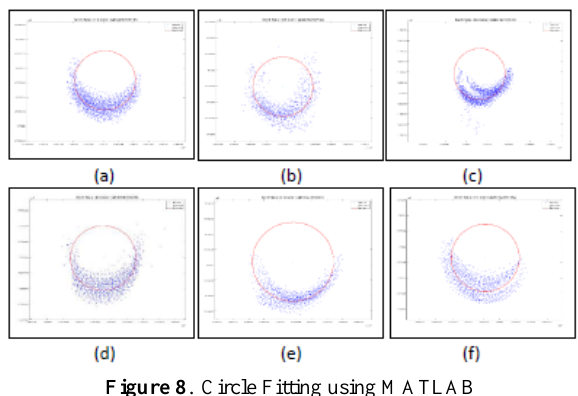
Figure 8 . Circle Fitting using